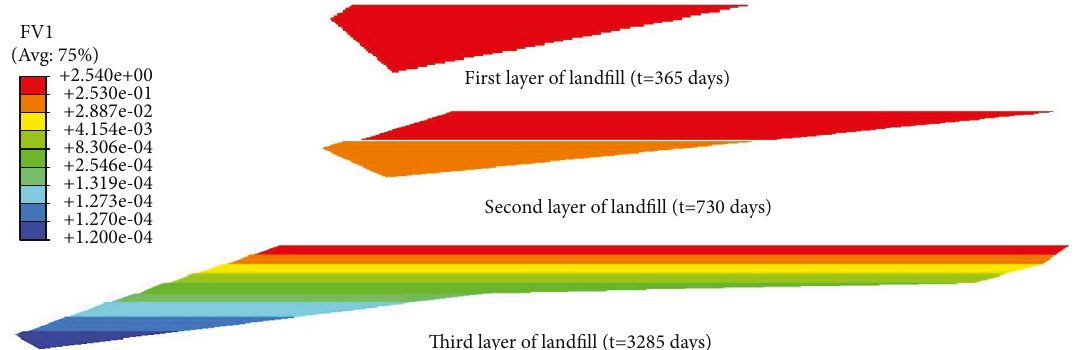
Third layer of landfill (t=3285 Figure 3: Simulated cloud chart of waste saturation